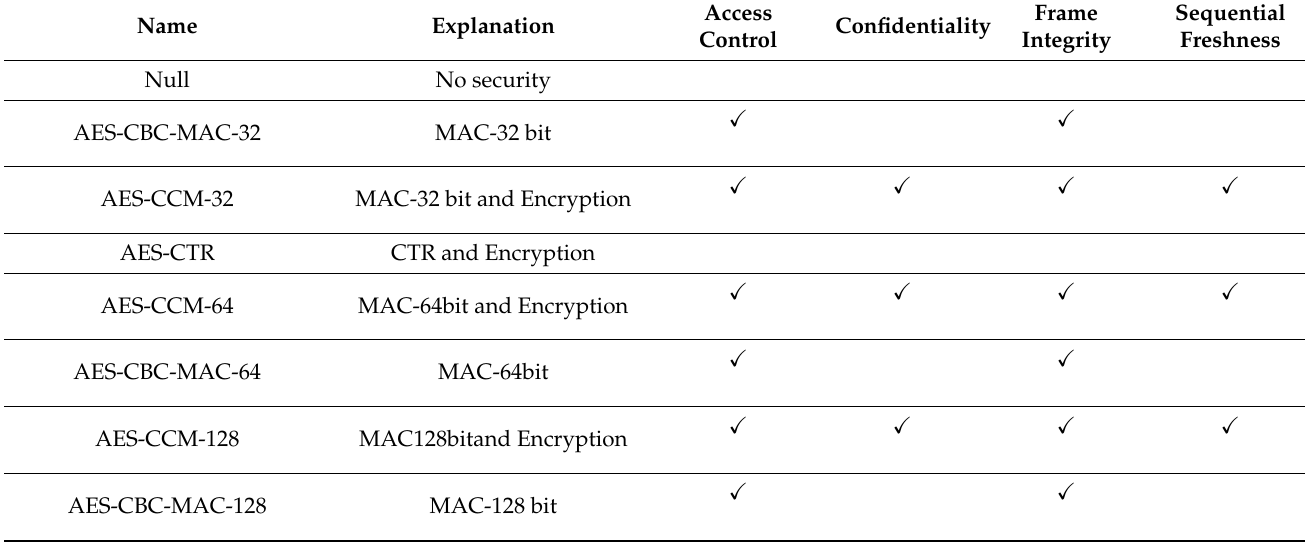
Table 2. IEEE 802.14.6 standard-related security.